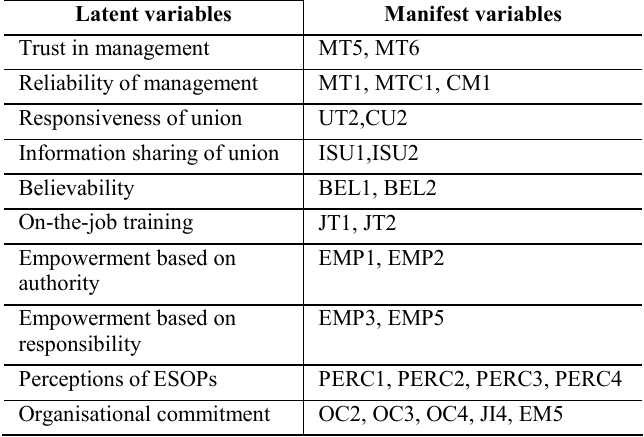
Table 1: Empirical factor structure for path analysis with latent